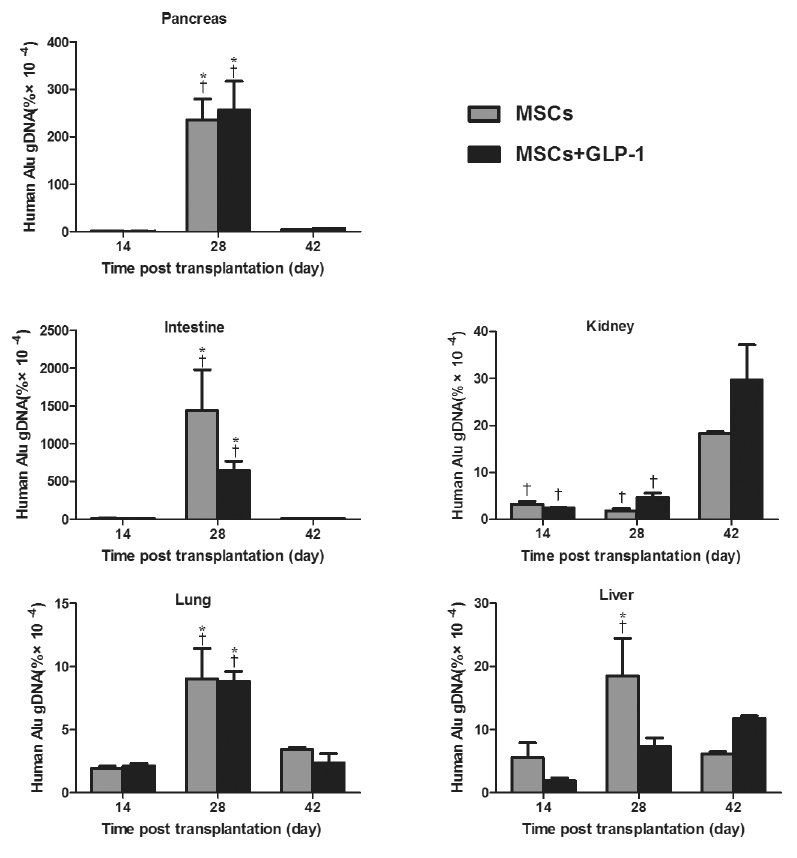
Figure 1. GLP-1 does not affect the migration and accumulation of infused MSCs into the pancreatic tissues of NOD mice. Diabetic NOD mice were infused with MSCs and treated intraperitoneally with GLP-1 or vehicle daily for 42 d. The indicated tissues were dissected from some mice of each group and the content of Alu element DNA was determined by quantitative RT-PCR. Data are expressed as the mean ± SEM of each group of mice (n = 6 per group per time point from three separate experiments. * P < 0.05 versus mice at 14 d post treatment. † P < 0.05 versus mice at 42 d post